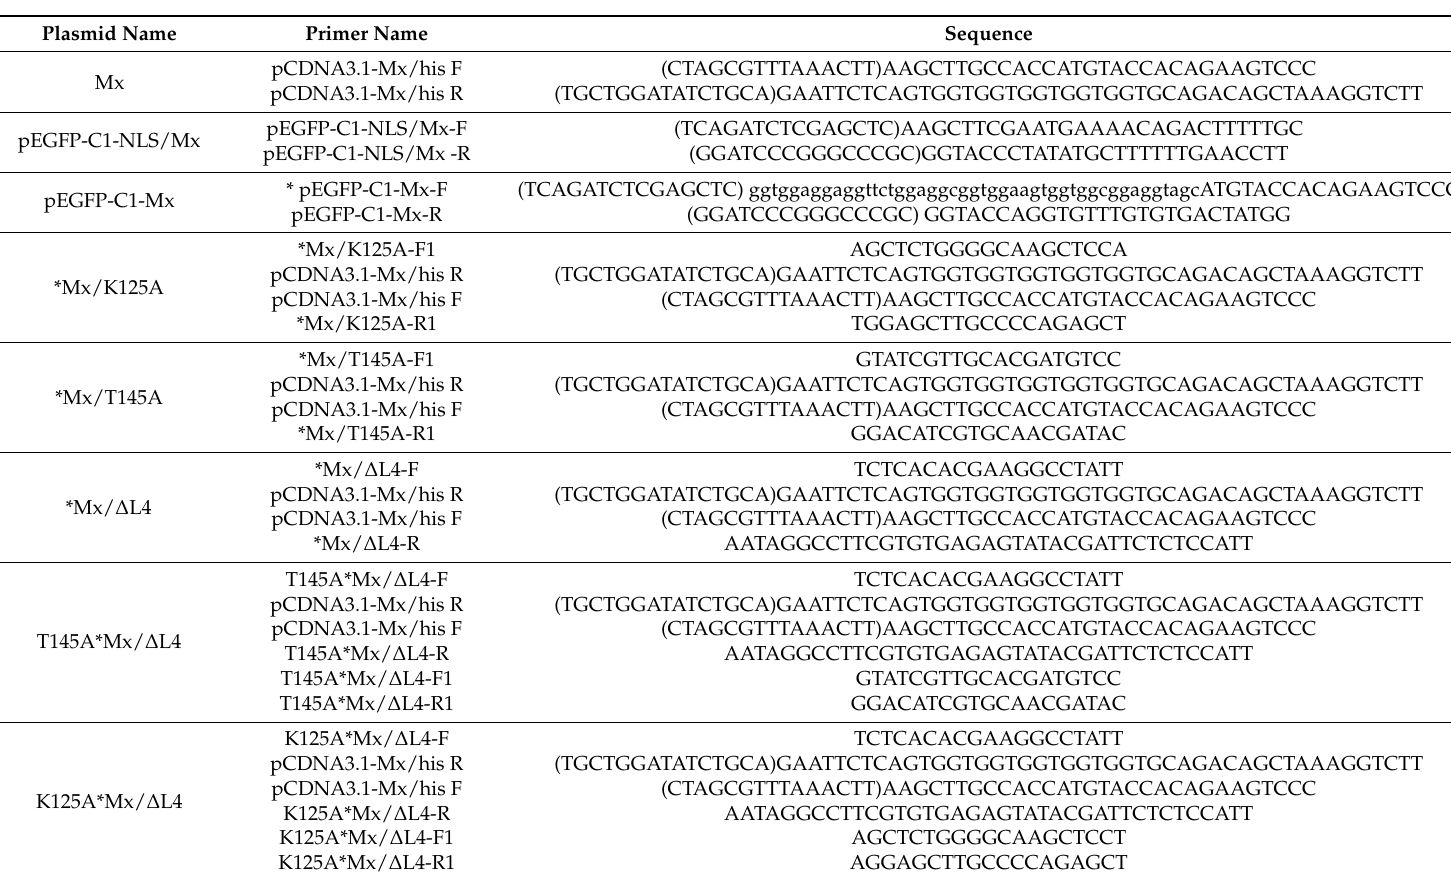
Table 1. Primer sequences for plasmid construction. The sequences in the parentheses represent the homologous arm sequences in the indicated vectors. In the pEGFP-C1-Mx-F primer (*), bases of lowercase letters are the hydrophobicity linker peptide (GGGGS) 3 . The nucleotides in red represent the six-His tag